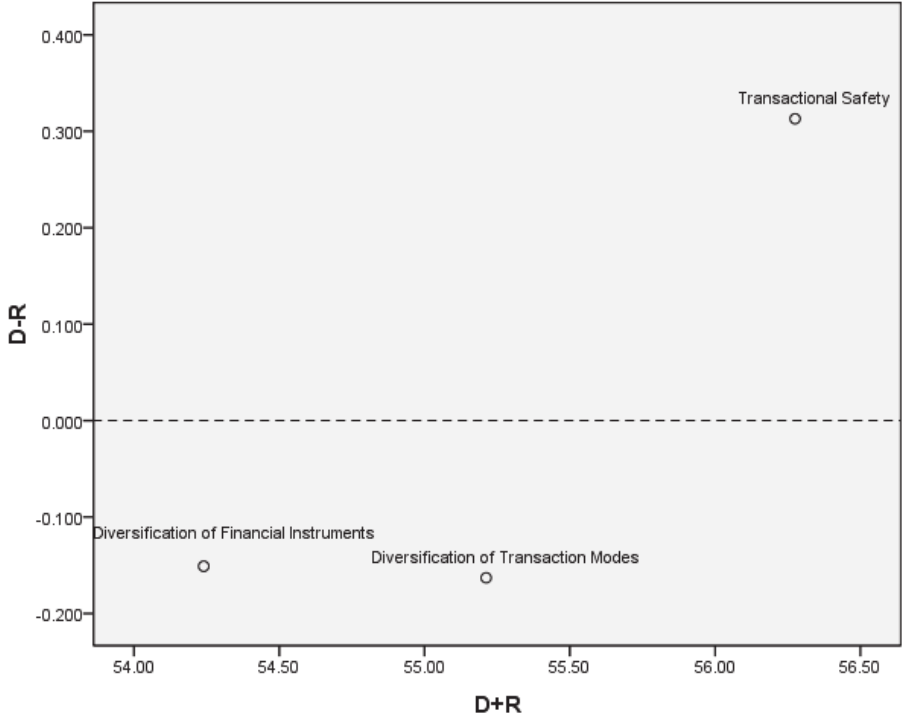
Figure 6. Causal diagram of sub-aspects of business process and product perspective criteria.